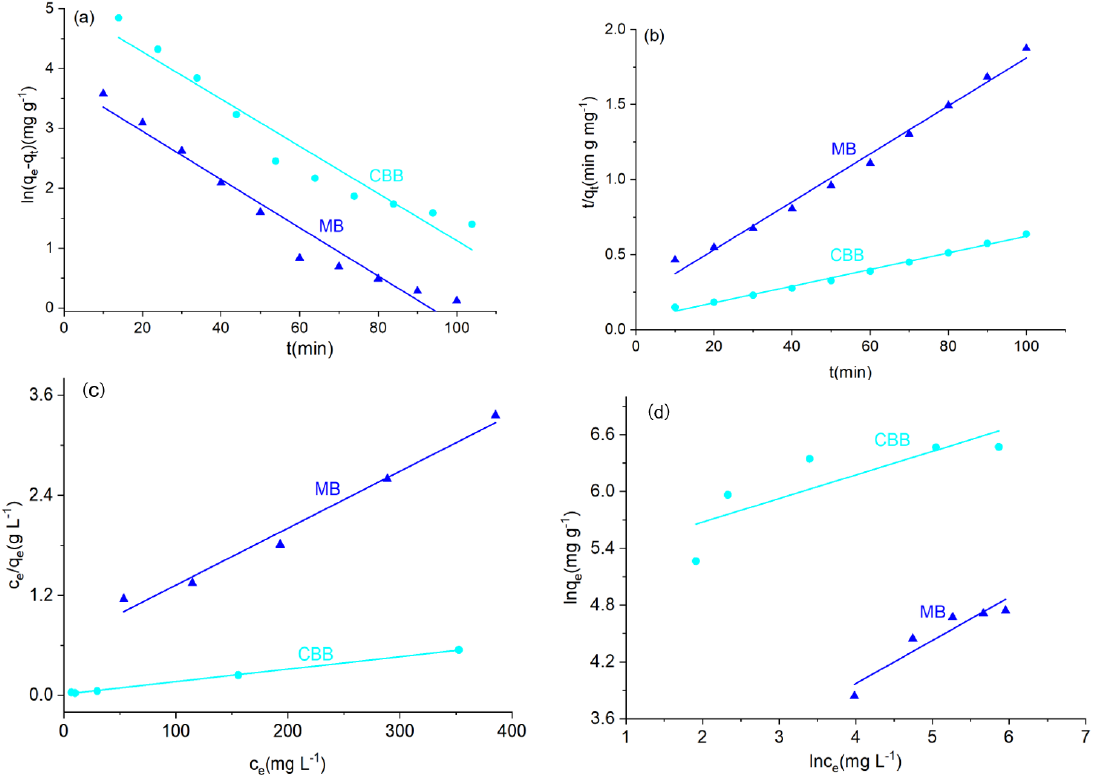
Figure 6. ( a ) Pseudo-first-order kinetic data. ( b ) Pseudo-second-order kinetic data. The dyes’ adsorption of A-4 analyzed using the ( c ) Langmuir model and the ( d ) Freundlich model .